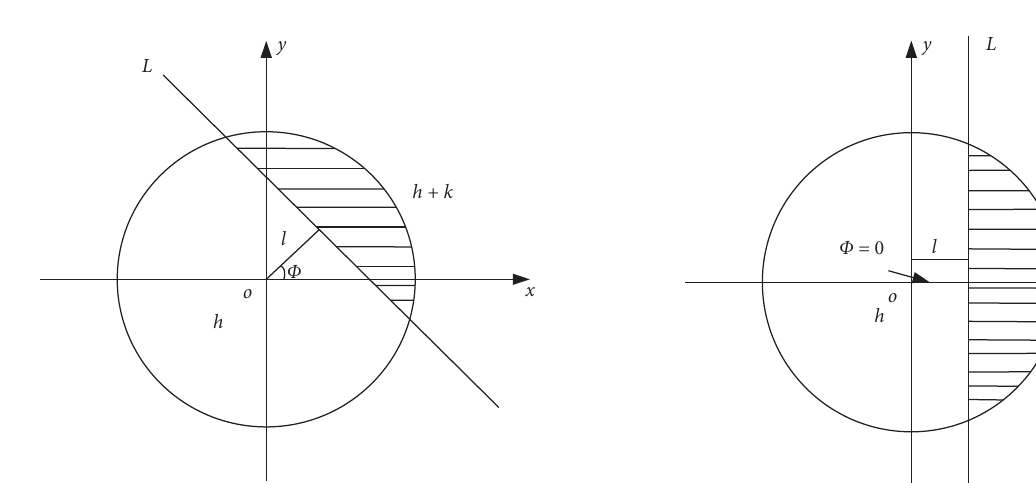
Figure 2: Subpixel edge image model after rotation. Table 1: M mask. 00